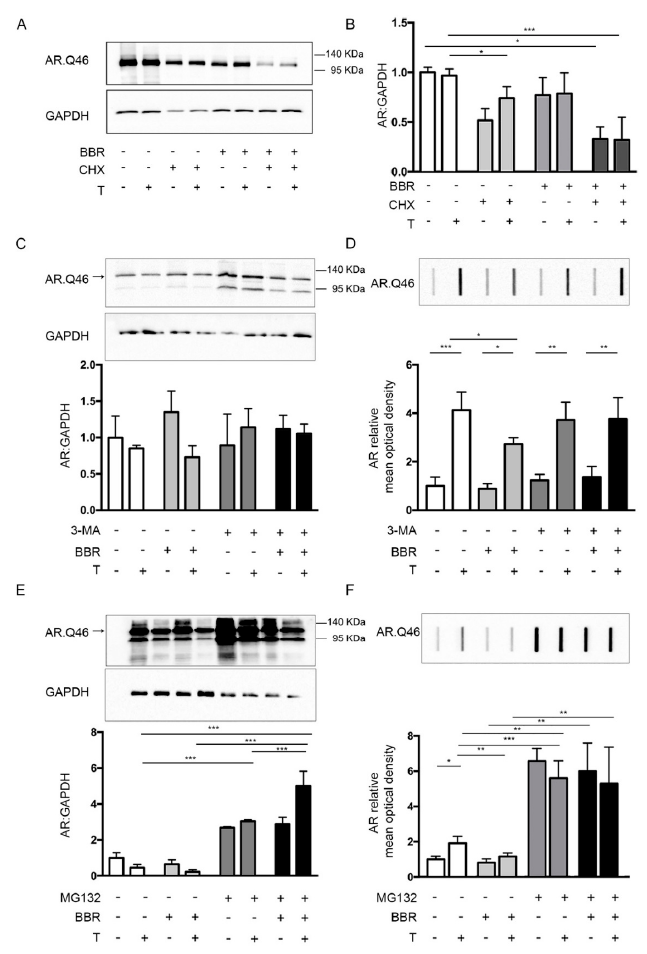
Figure 2. BBR pro-degradative activity on ARpolyQ. ( A ) WB analysis on NSC34 cells transfected with AR.Q46 in absence or in presence of 10 nM testosterone. To inhibit protein synthesis the cells were pretreated with 20 µ M cycloheximide (CHX) and then treated with 0.2 µ M BBR or DMSO as vehicle control for 48 h. GAPDH was used as loading control. ( B ) The bar graph represents the mean optical density ± SD of AR: GAPDH (n = 3) (* p < 0.05, *** p < 0.001, two-way ANOVA, followed by Tukey’s test). ( C , F ) NSC34 cells transfected with AR.Q46 in absence or in presence of 10 nM testosterone and treated with 0.2 µ M BBR and with 10 mM 3-MA ( C , D ) or 10 µ M MG132 ( E , F ) to inhibit autophagic or proteasomal activity, respectively. ( C , E ) WB analyses were performed; GAPDH was used as loading control; the bar graphs represent the mean optical density ± SD of AR: GAPDH (n = 3). *** p < 0.001, two-way ANOVA, followed by Tukey’s test). ( D , F ) FRA was performed. The bar graphs represent the mean optical density of AR ± SD (n = 3). (* p < 0.05, ** p < 0.01, *** p < 0.001, two-way ANOVA, followed by Tukey’s